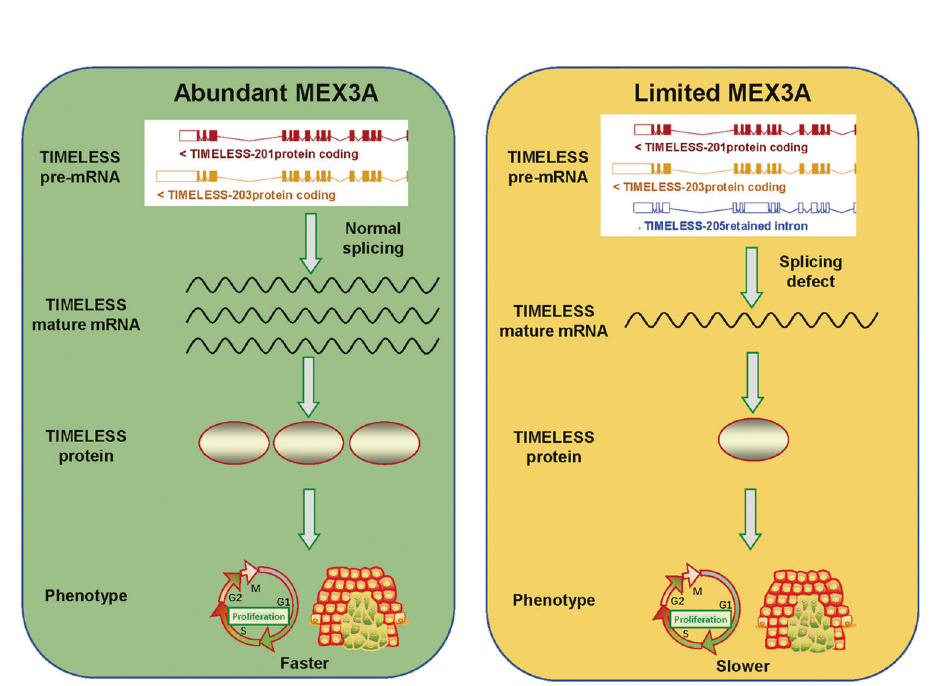
Fig. 8 Model showing the effect of MEX3A/TIMELESS signaling on the malignancy of ovarian cancer cells. Abundant MEX3A regulates TIMELESS expression and performs oncogenic functions through maintaining the normal splicing of TIMELESS. At the de fi ciency of MEX3A, TIMELESS splicing goes wrong which leads to reduction of TIMELESS and decreases the oncogenic ability of